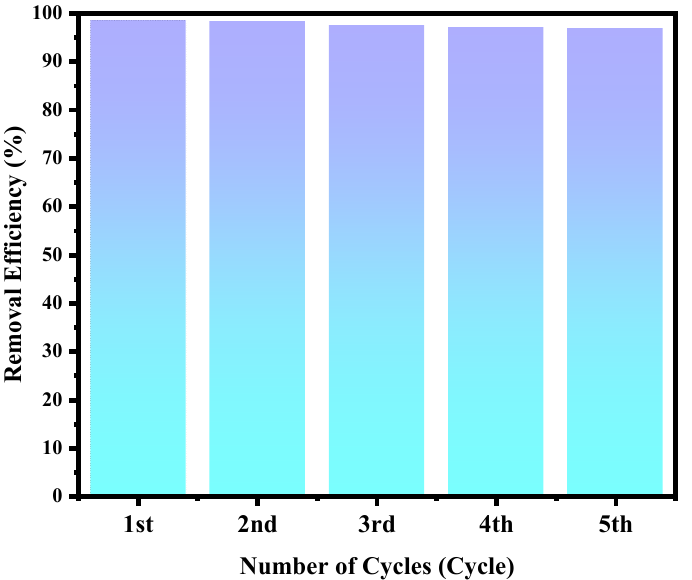
Figure 7. The MZG3 photocatalytic activity for degradation of organic pollutant remained stable (about 97%) throughout five consecutive cycles.